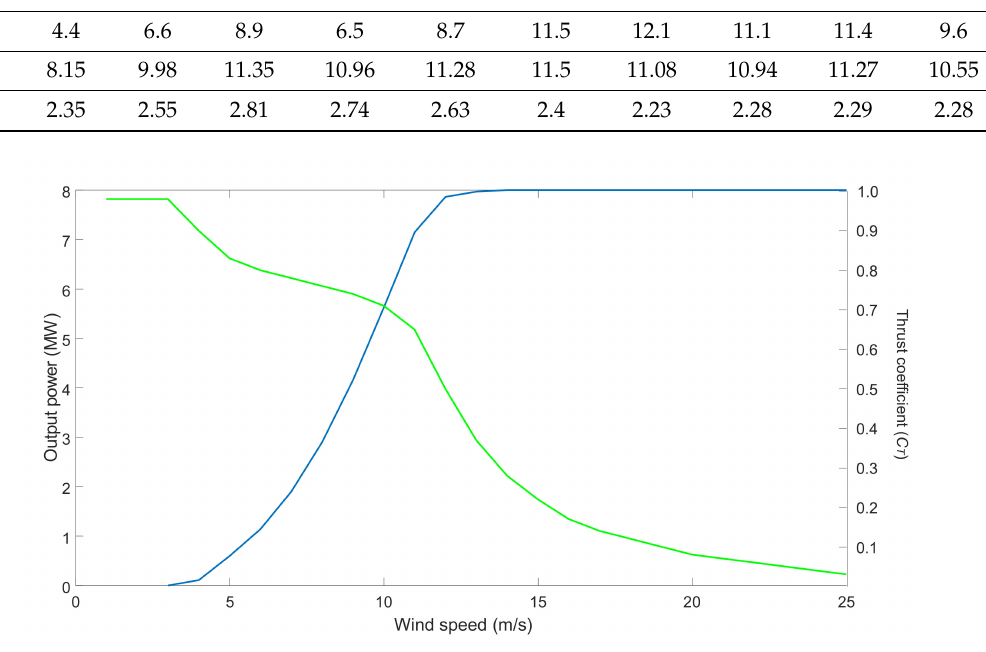
Figure 5. Power and thrust curves of the LEANWIND 8 MW wind turbine. Data retrieved from